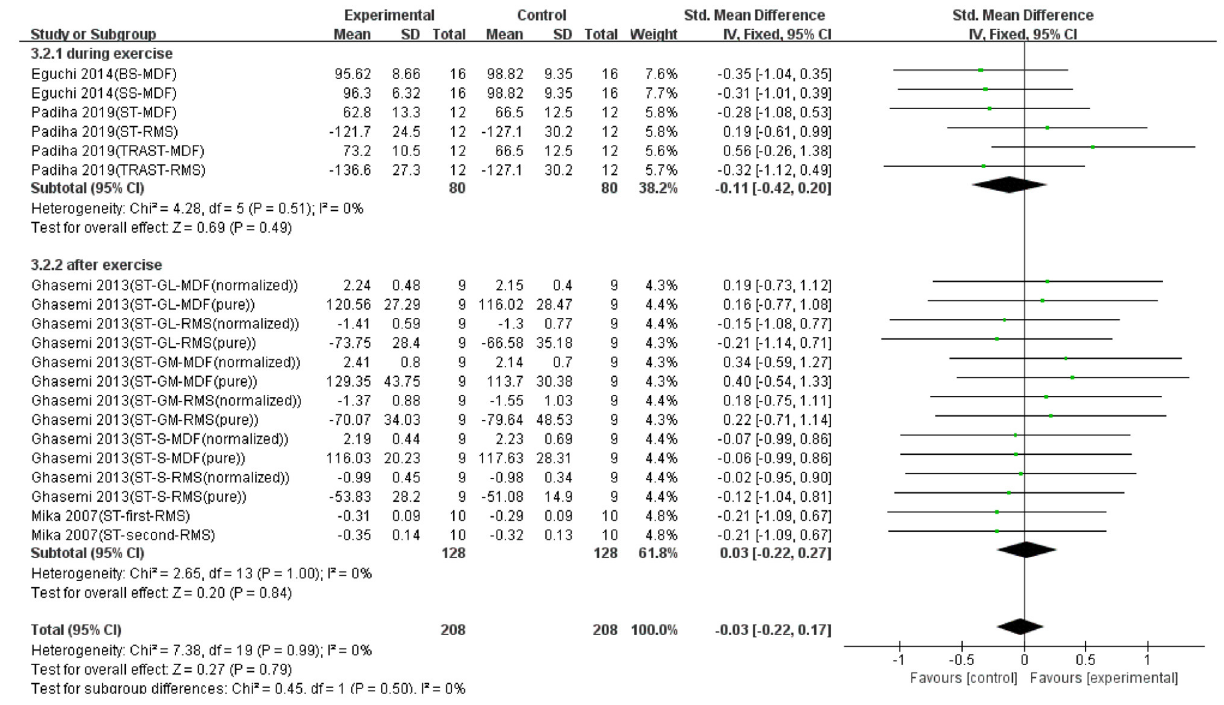
subgroup analysis based on the conducted time of compression (i.e., during exercise and after exercise). Figure 6 shows that when compression was applied during exercise, the recovery effect was significantly more effective (SMD